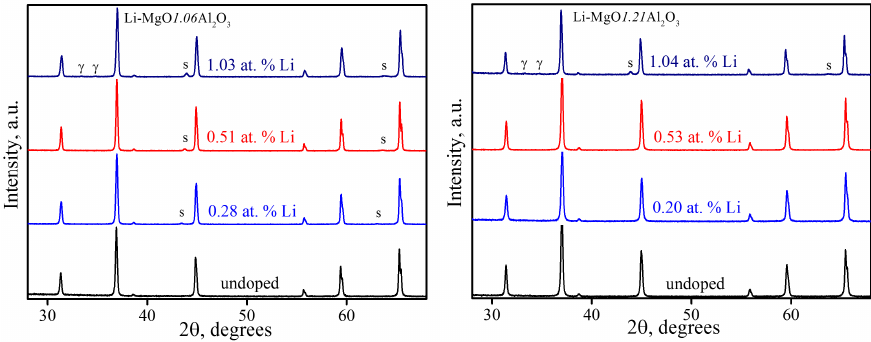
Figure 5. XRD patterns of Li-doped MgO· n Al 2 O 3 ( n = 1.06 and 1.21) SPS-processed samples. The precipitated MgO s.s. and γ -LiAlO 2 phases are marked by s and γ , respectively. In general, for samples containing up to 53.0 at. % Li, the cell parameters were 8.0810 ± 0.0005 Å and 8.0652 ± 0.0005 Å for n = 1.06 and 1.21, respectively. At higher Li content, both 1.03 at. %